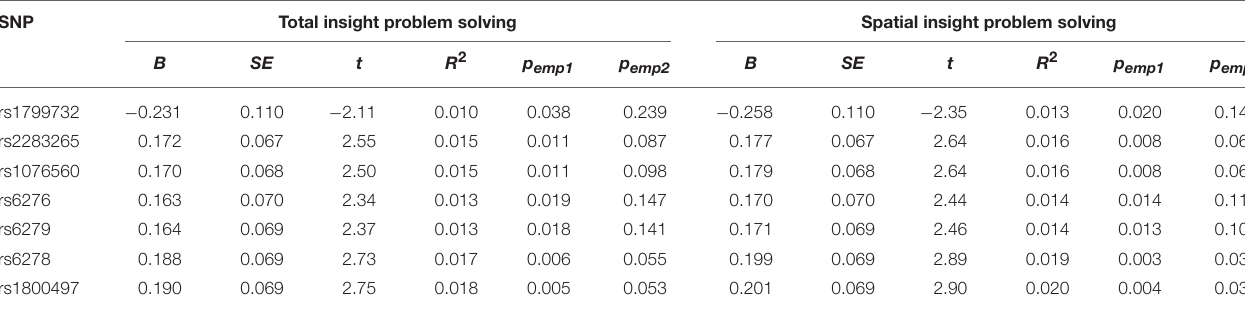
TABLE 2 | Summary results of significant SNPs associated with insight problem solving. SNP Total insight problem solving Spatial insight problem